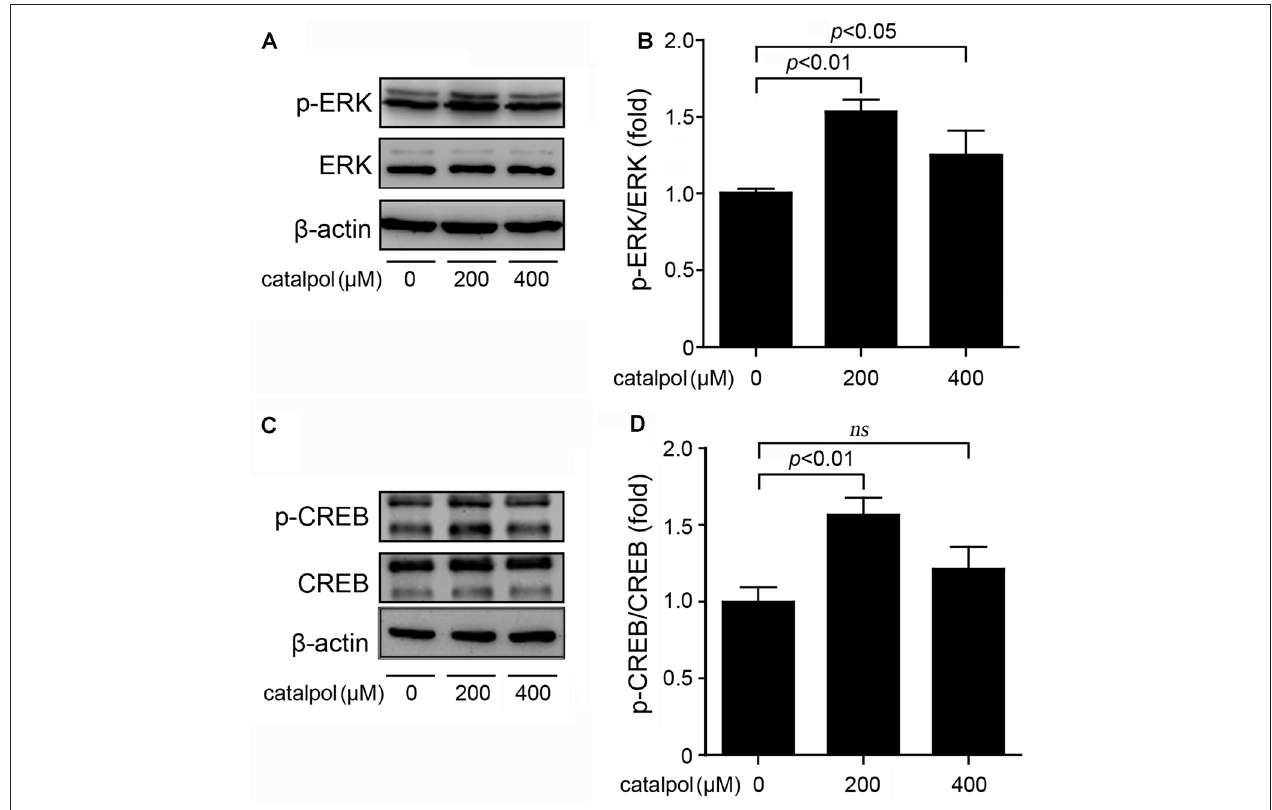
FIGURE 4 | Catalpol activated the extracellular signal-related kinase/cAMP-response element binding protein (ERK/CREB) signal pathway in SweAPP N2a cells. (A,B) SweAPP N2a cells were treated with catalpol at 200 µ M or 400 µ M for 1 h. (A) Immunoblotting analyses and (B) quantifications showed that the phosphorylation levels of ERK was markedly increased after treatments with catalpol. (C) Immunoblotting analyses and (D) quantifications showed that catalpol significantly increased the phosphorylation levels of the transcription factor CREB, which is the downstream of ERK. The data are expressed as the mean ± SEM. n = 3. The p values were calculated using one-way